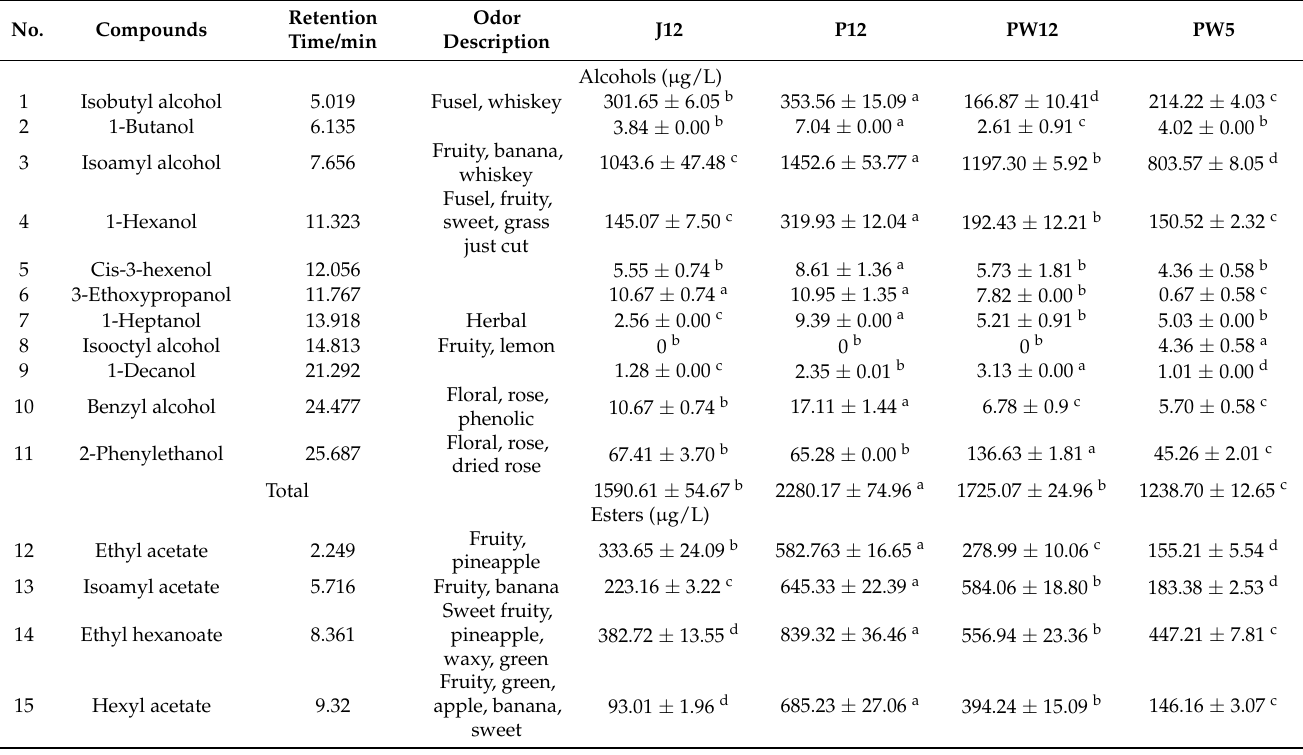
Table 3. Volatile compounds identified in the investigated